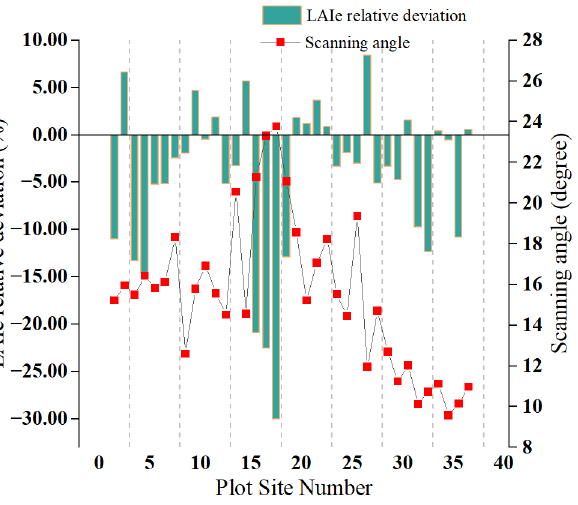
Figure 14. Relative deviation in the UAV-LS-estimated LAIe compared to the plot-level LAIe.